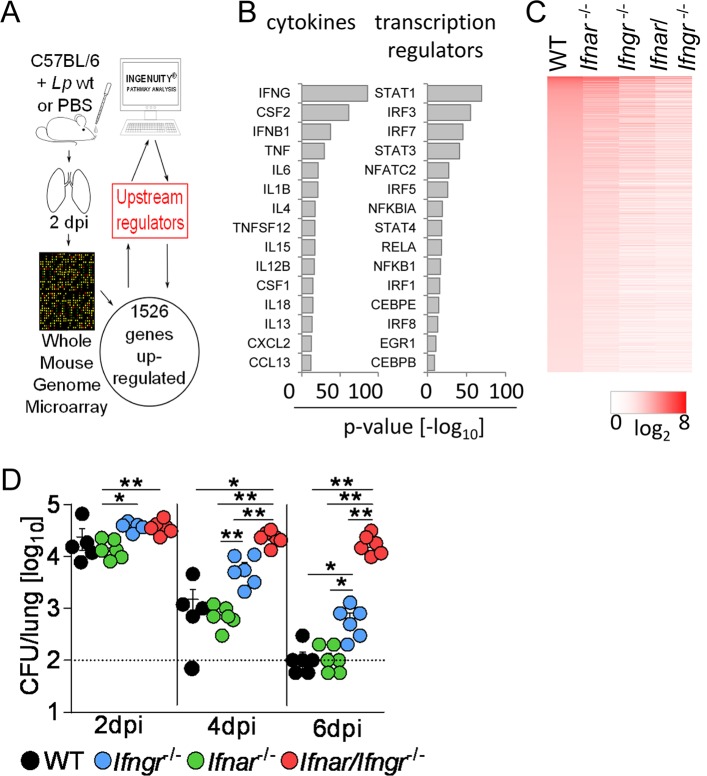
Type I and II IFNs are main regulators of gene expression during L. pneumophila infection.(A) Workflow for upstream regulator analysis. (B, C) WT (B) or WT, Ifnar
-/-, Ifngr
-/- and Ifnar/Ifngr
-/- mice (C) were infected with L. pneumophila or treated with PBS. Mice were sacrificed 2 d p.i., and microarray analysis performed from lung RNA. Up-regulated genes in L. pneumophila-infected WT mice compared to controls were analyzed for their predicted upstream regulators (B). Heat map of microarray analysis of infected versus PBS-treated mice for wild-type and respective knock-out strains (C). 5 mice per group, pooled for RNA extraction and subsequent analysis. (D) Bacterial loads in the lungs of L. pneumophila infected WT, Ifnar
-/-, Ifngr
-/- and Ifnar/Ifngr
-/- mice are depicted. Data represent mean + s.e.m. of 5–6 mice per group. Dotted line indicates lower detection limit, * p<0.05, ** p<0.01 (Kruskal-Wallis analysis of variance followed by Mann-Whitney U test with Bonferroni correction for multiple comparisons).